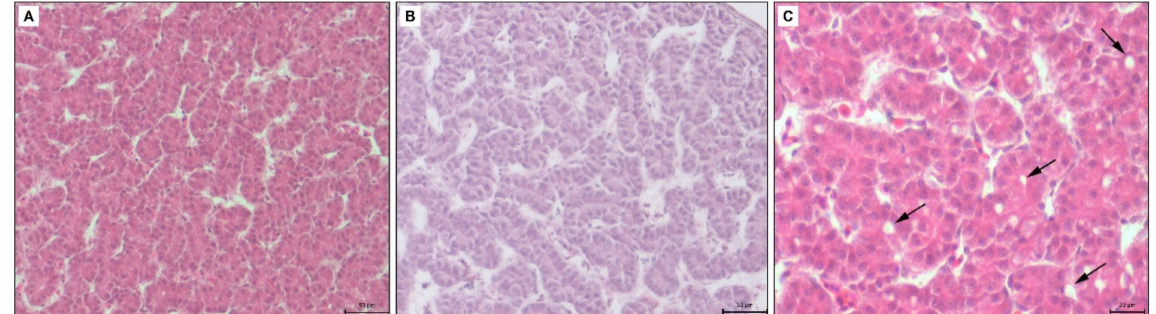
Figure 5. ( A ): Microphotograph of the chicken liver in control group, H-E staining, scale bar: 50 µ m, ( B ): Microphotograph of the chicken liver in experimental group—5 µ L of DMSO administration, H-E staining, scale bar: 50 µ m, ( C ): Microphotograph of the chicken liver in experimental group—10 µ L of DMSO administration, black arrows—dilated bile canaliculi, H-E staining, scale bar: 20 µ m.